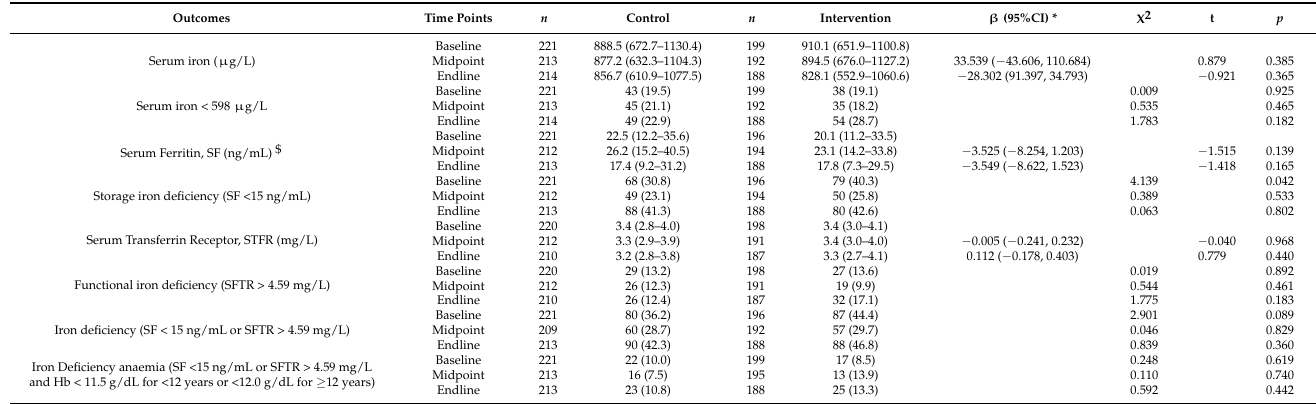
Table 6. Biomarkers of Iron status by study arm at baseline, midpoint and